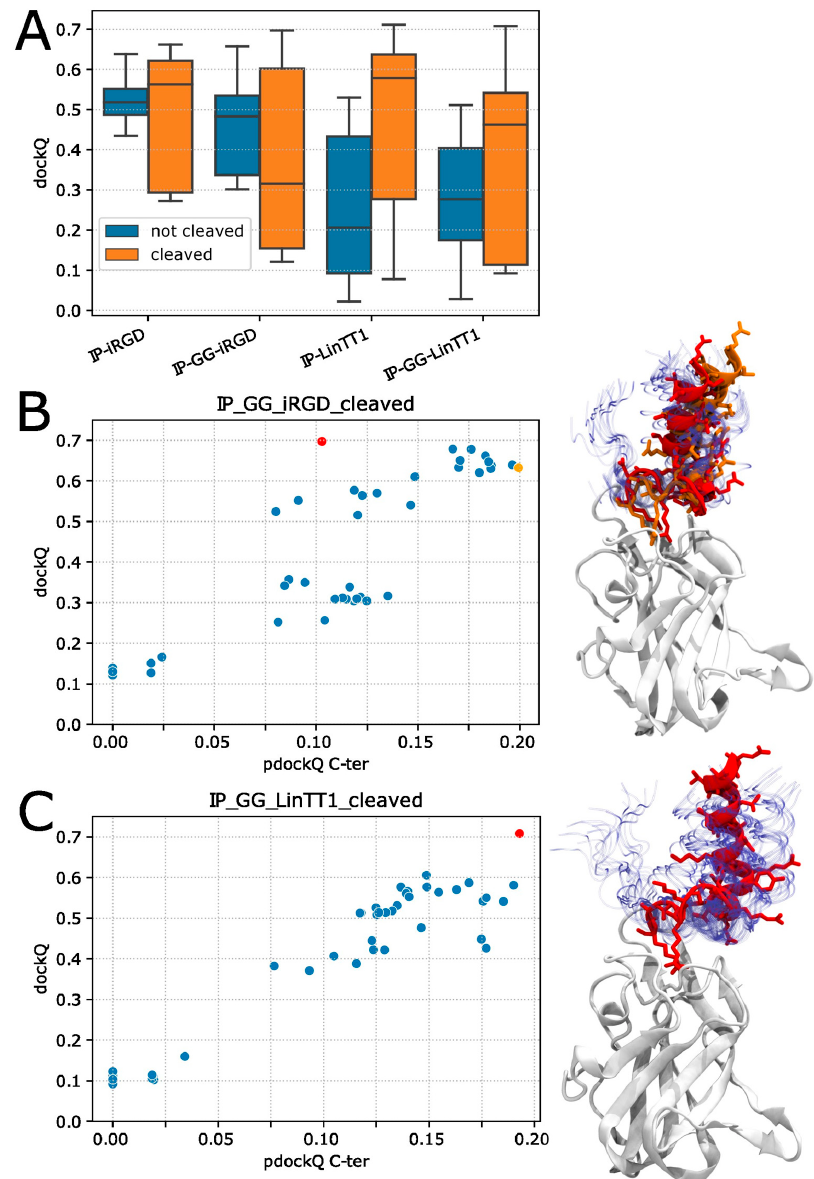
Figure 1. Quality measurement of Alphafold models. ( A ) Boxplot of the DockQ score, the four peptides IP-iRGD, IP-GG-iRGD, IP-LinTT1 and IP-GG-LinTT1 (50 alphafold models each) were studied in their uncleaved and cleaved forms and displayed as blue and orange boxplots, respectively. Scatterplot of DockQ versus pdockQ scores for the 50 models of IP-GG-iRGD-cl ( B ) and IP-GG-LinTT1-cl ( C ), the red and orange dots show the best models according to their dockQ and pdockQ scores. The left panels display the 50 superimposed alphafold models, Neuropilin-1 is shown as a white cartoon, as the 50 peptide models are shown as blue transparent ribbons, the best peptides are shown in colored cartoons according to scatterplot colors (orange and red); for the same models, the peptide atoms are shown as colored sticks. Larger images of the 3D structures are available as supplementary information (Figure